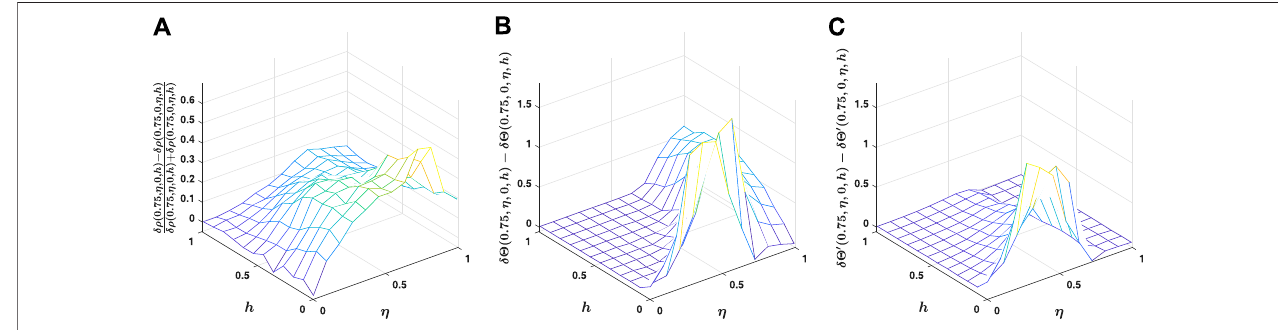
FIGURE 4 | Asymmetry between signal comprehension and production. Asymmetry in density fl uctuations δρ ( 0 . 75 , η , 0 , h )− δρ ( 0 . 75 , 0 , η , h ) δρ ( average direction of motion from the environmental direction δ Θ ( 0 . 75 , η , 0 , h ) − δ Θ ( 0 . 75 , 0 , η , h ) , (B) , and asymmetry in average angular deviation of individuals from environmental direction δ Θ ′ ( 0 . 75 , η , 0 , h ) − δ Θ ′ ( 0 . 75 , 0 , η , h ) , (C) , in the η − h plane are plotted. Production noise increases density fl uctuations and deters the inference capability of the population. Here, L (cid:2) 10, v 0 (cid:2) 0 . 1, ω (cid:2) 0 . 25, η R (cid:2) 0 . 75 and ρ (cid:2) 1. The simulation is run for T (cid:2) 4000 time steps, and an average over the last 2000 time steps and 24 runs is taken. ε taken equal to π /